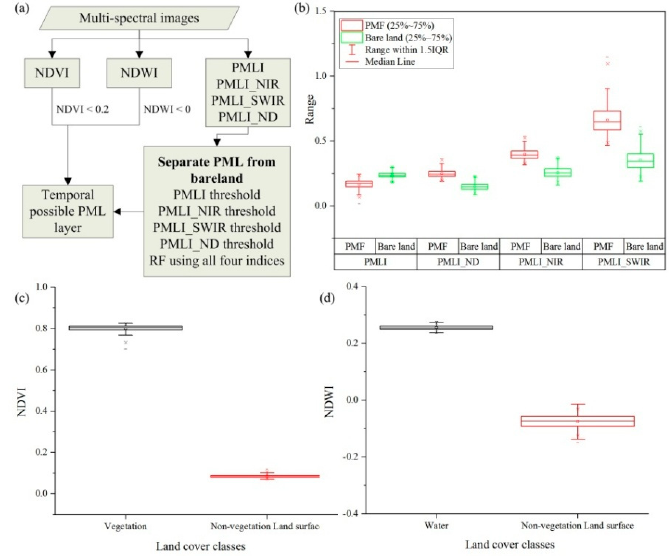
Figure 5. Flowchart for generating the “temporal possible PML layer.” ( a ) Decision tree designed for temporal possible PML layer identification, ( b ) PML indices (PMLI_NIR, PMLI_SWIR, and PMLI_ND values for PML and bare land training samples.